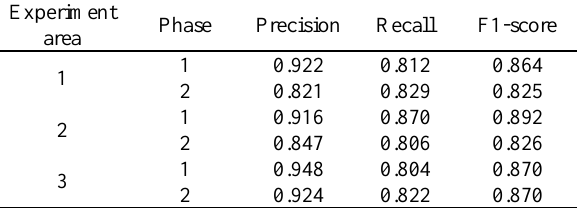
Table. 2 Change detection accuracy of traditional